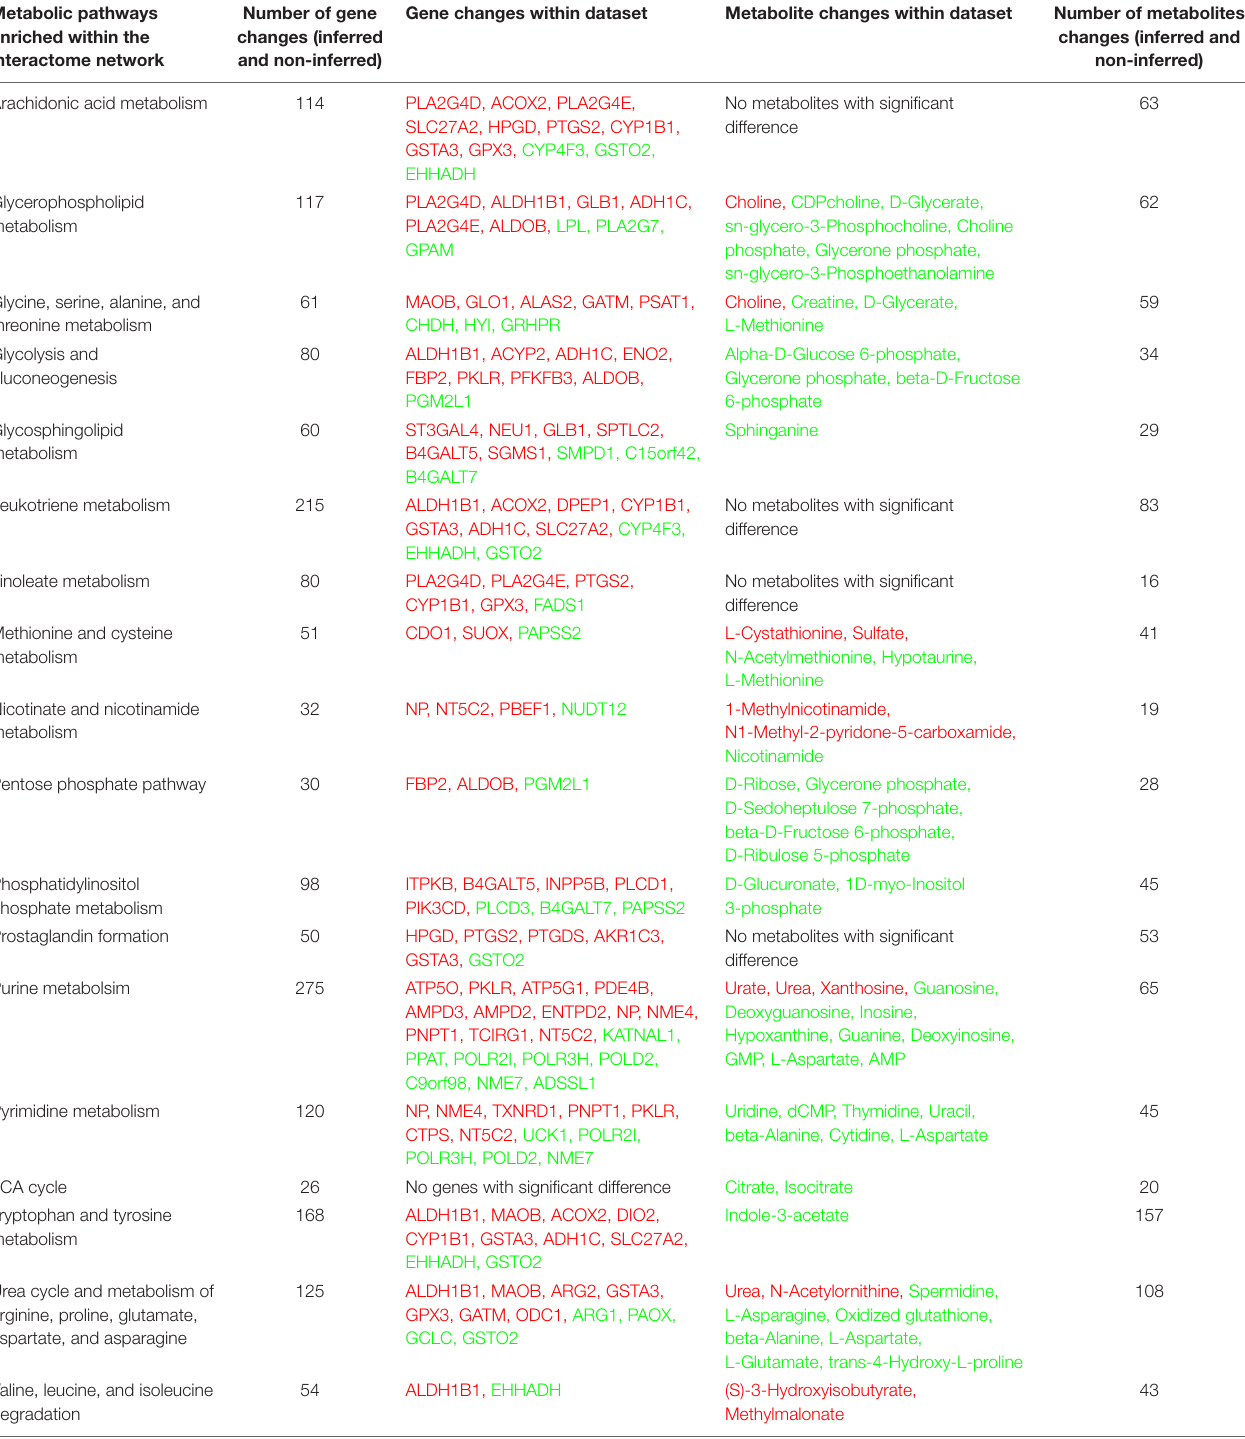
TABLE 6 | Metabolic pathways identified from the interactome